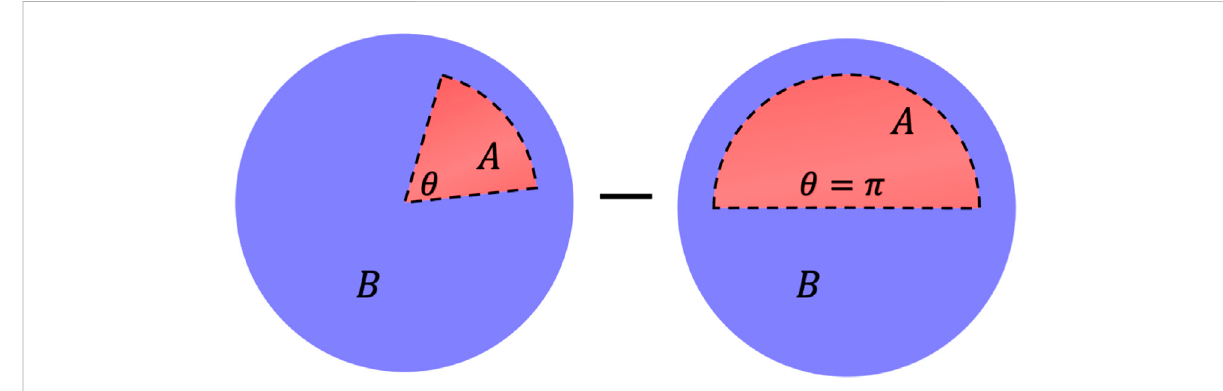
FIGURE 2 The non-smooth cutting schematic diagram of a bipartite fi nite disk and the subtraction rule is applied to extract pure angle contribution.